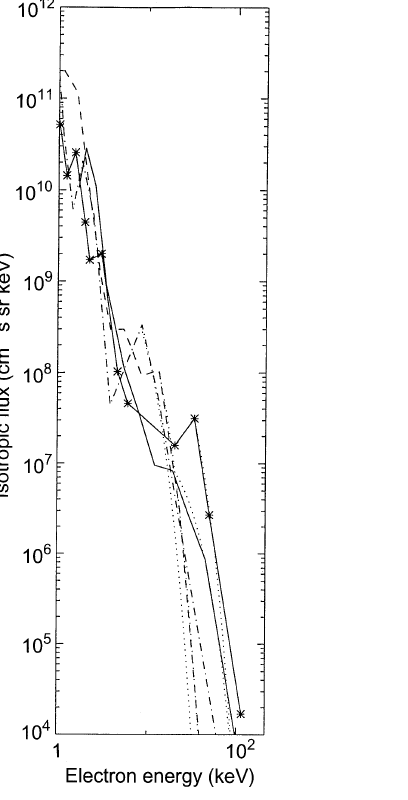
Fig. 2. Accelerated Maxwellian distribution functions for precipita- ting electrons fitted ( dotted lines ) to 5-s-resolution spectra for the onsets on 5 October 1986 ( —* ), 27 February 1992 (-) and the WTS events on 24 January 1993 ( — · ), 25 January 1993 ( — ). The potential drop and thermal energy are 30 kV and 6 keV, respectively, for the onset event on 5 October 1986, and for the onset event on 27 February 1992 the values are 20 kV and 8 keV. Corresponding values for the WTS event on 24 January 1993 are 8 kV and 2 keV, and for the WTS event on 24 January 1993 the values are 14 kV and 2.5 keV